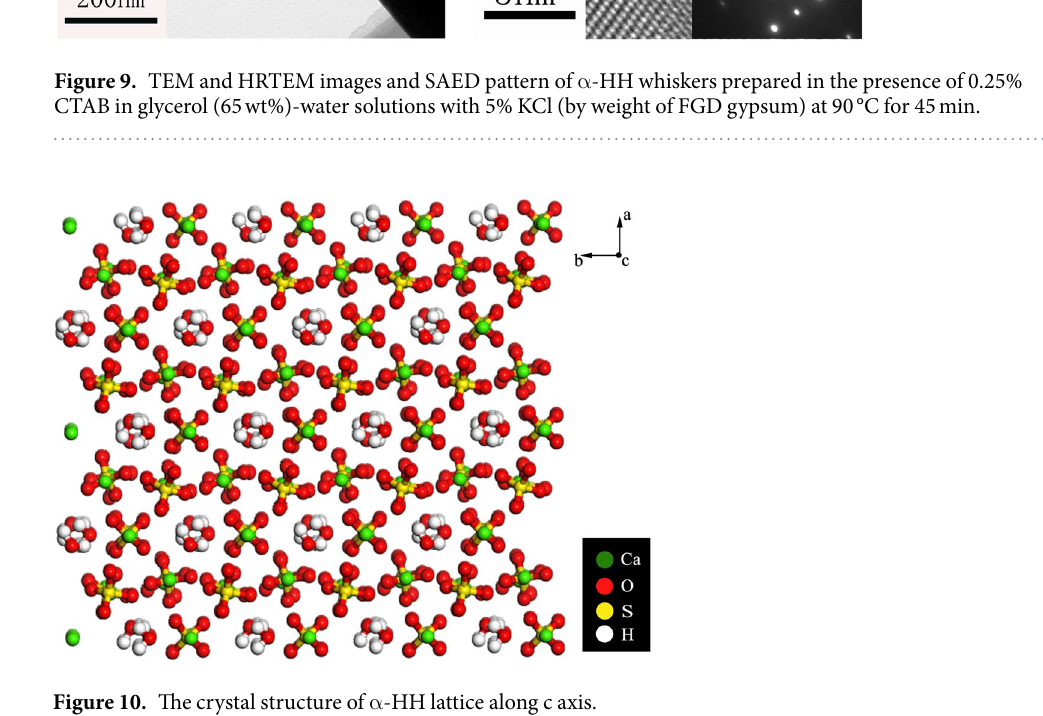
Figure 10. The crystal structure of α -HH lattice along c